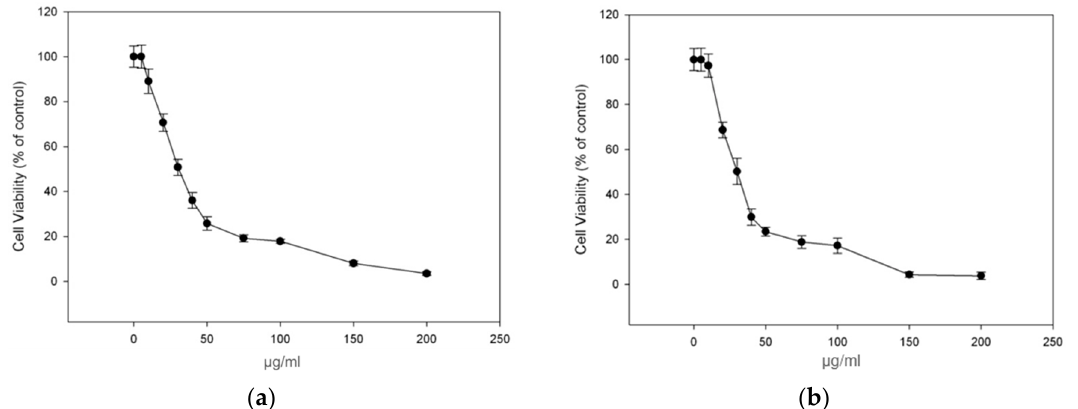
Figure 2. Cytotoxicity profile of propolis extracts in human immortalized keratinocyte (HaCaT) cells. Cells were incubated for 24 h with increasing concentrations (0–200 μ g/mL) of each propolis extract: PR_1b ( a ) and PR_9b ( b ). Cell viability was determined by the SRB assay. The results are shown as the mean ± SD of three independent experiments.